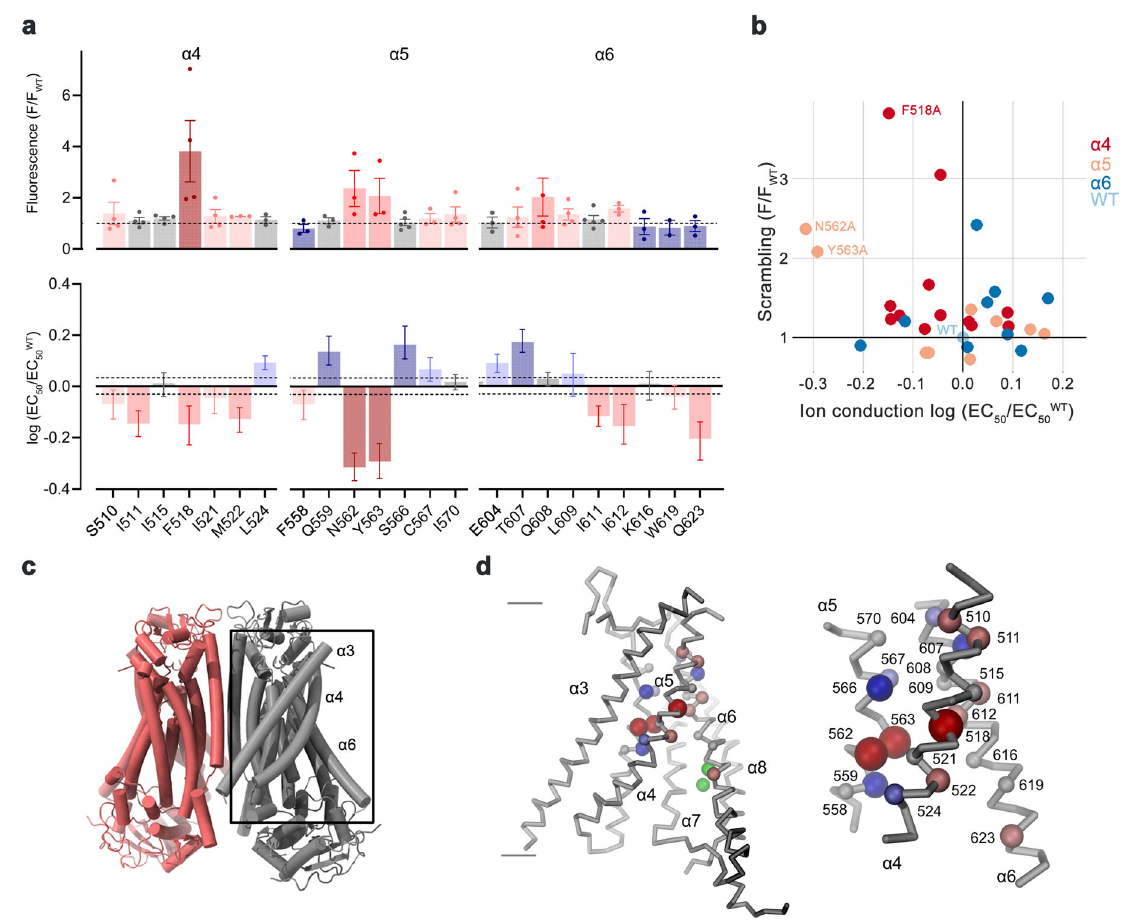
Fig. 1 | Activation properties of pore mutants. a Alanine scan of residues lining the pore of the closed ion and lipid permeation region of TMEM16F. Top, initial fl uorescence in a cell-based lipid scrambling assay monitoring the binding of fl uorescently tagged annexin V to phosphatidylserine at the cell surface. Values re fl ecting the lipid transport activities of TMEM16F mutants at resting Ca 2+ -con- centrations were normalized to the fl uorescence of WT (dashed line). Data show mean of the displayed number of experiments, errors are s.e.m. Bottom, EC 50 of Ca 2+ activation recorded in excised patches. Data show EC 50 values derived from a Hill- fi t of dose-response curves shown in Supplementary Fig. 1b. Mutant EC 50 s are expressed as log-ratio compared to WT, errors are 95% con fi dence intervals. Dashedlinesrefertothe95%con fi denceintervalofWT.Colorsre fl ectdirectionand